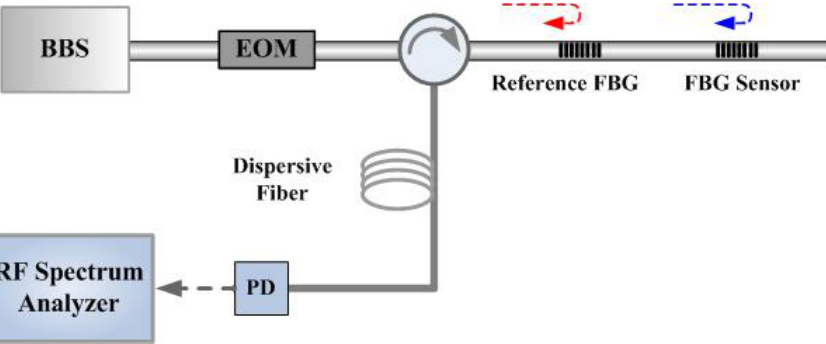
Figure 14. The operation diagram of the intensity-modulated fiber Bragg grating sensor based on RF signal